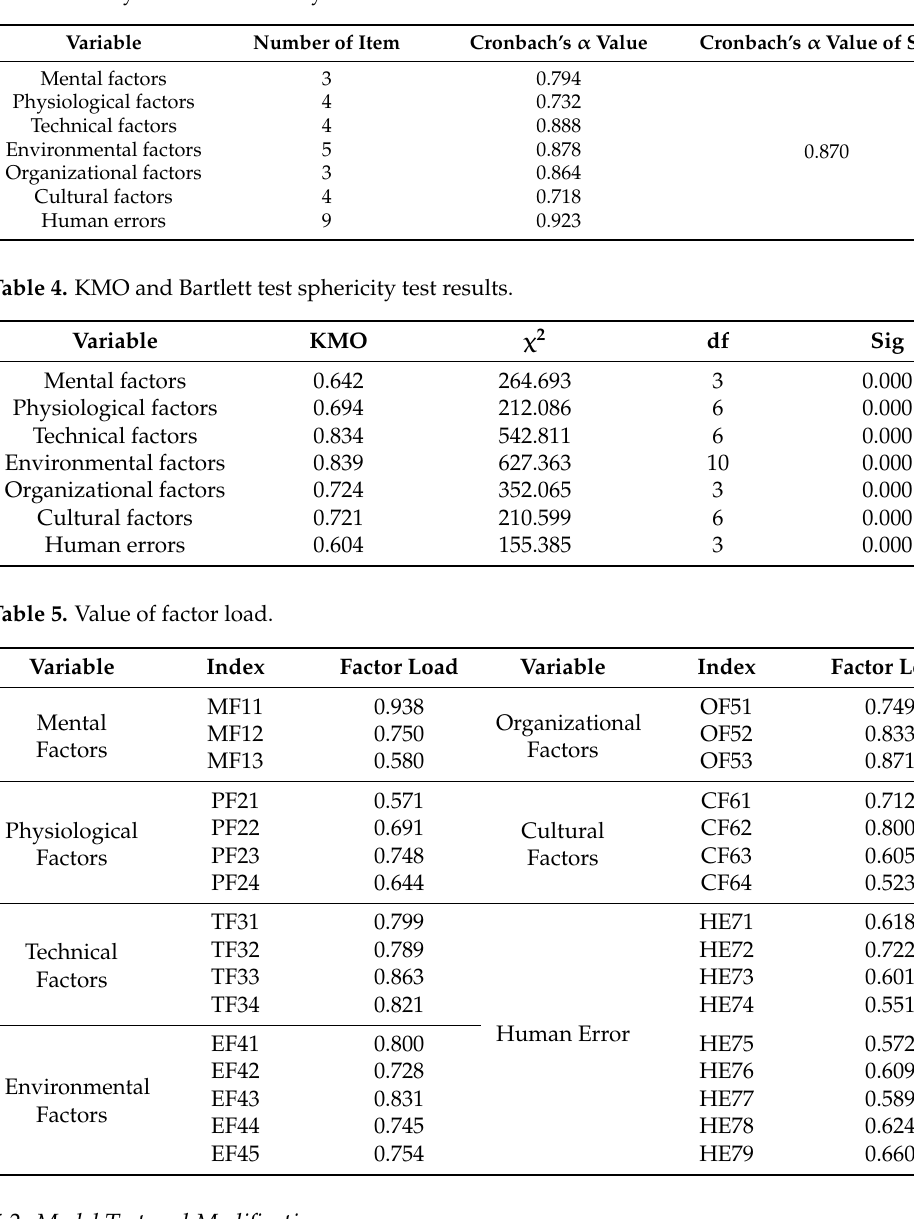
Table 3. Analysis of the reliability of each dimension.